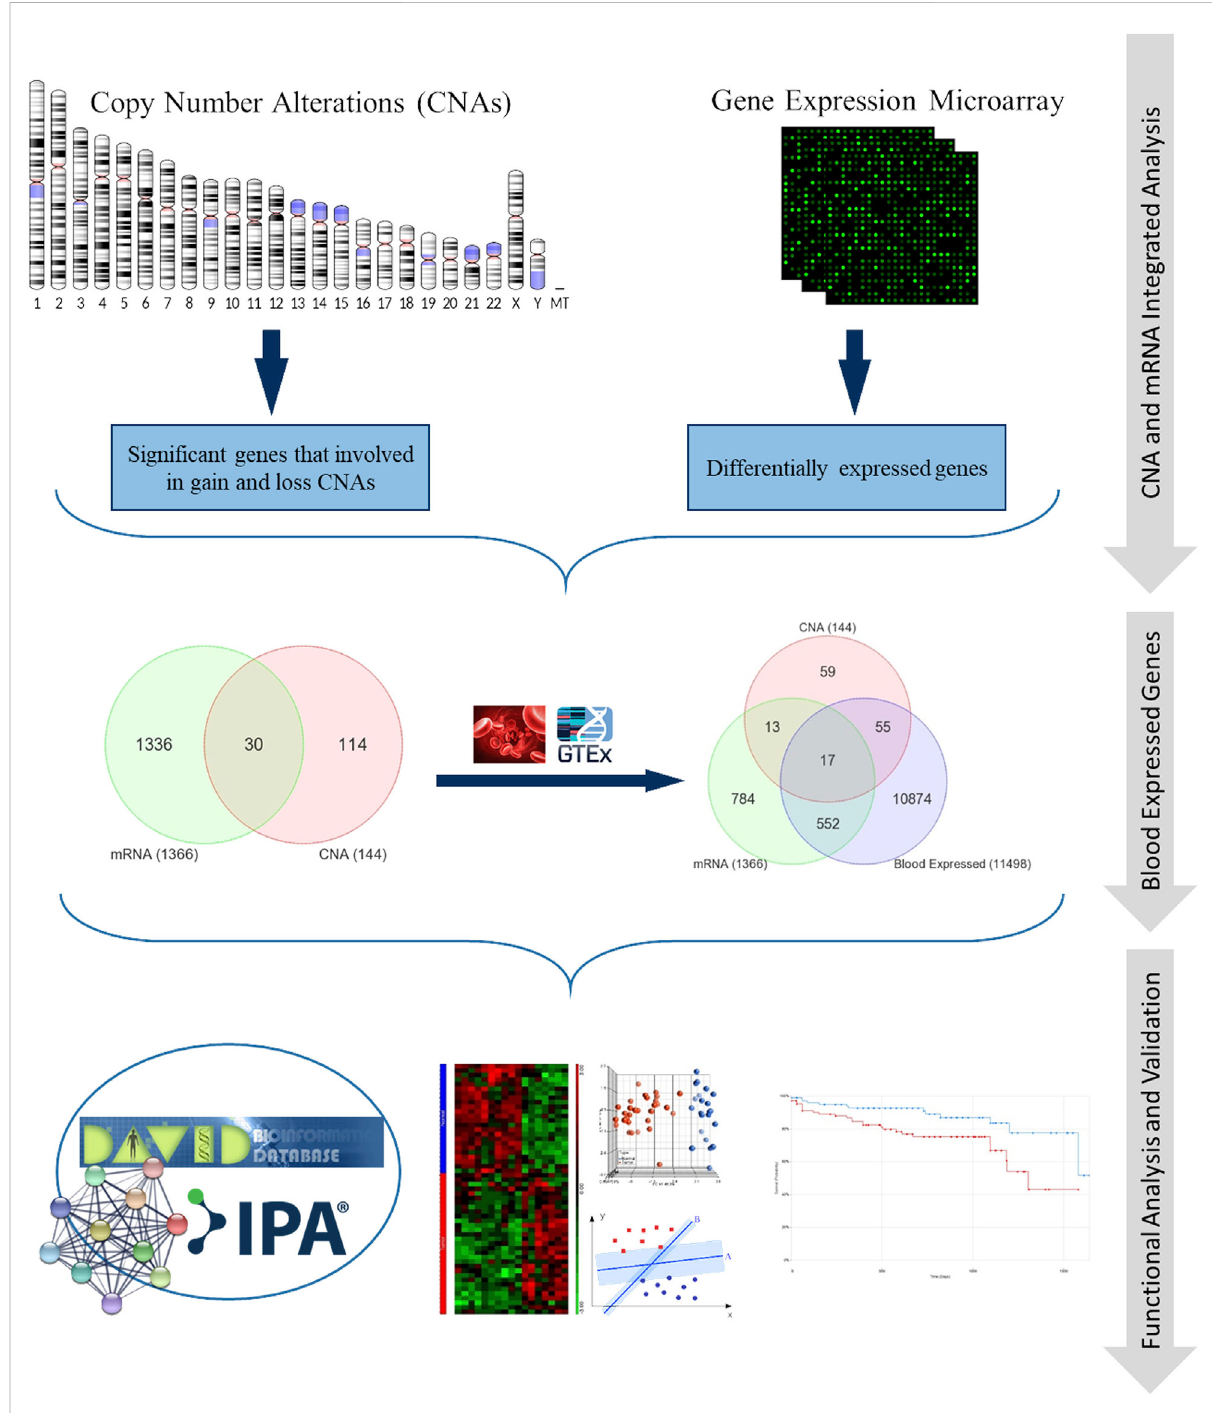
FIGURE 1 Schematic diagram illustrating the